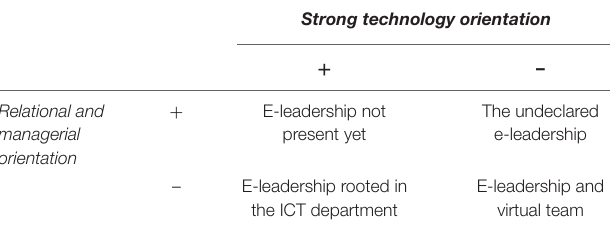
TABLE 2 | Our proposal of typologies of